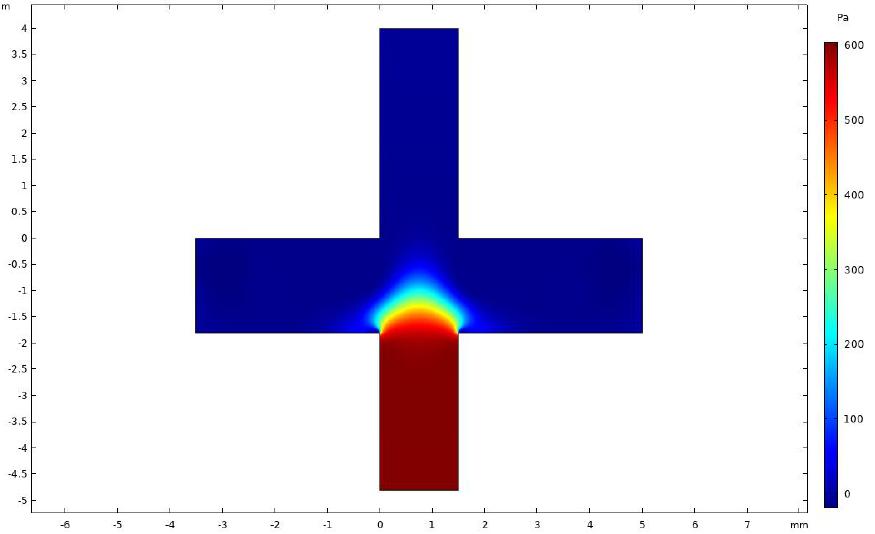
Figure 6. Pressure distribution in VI.